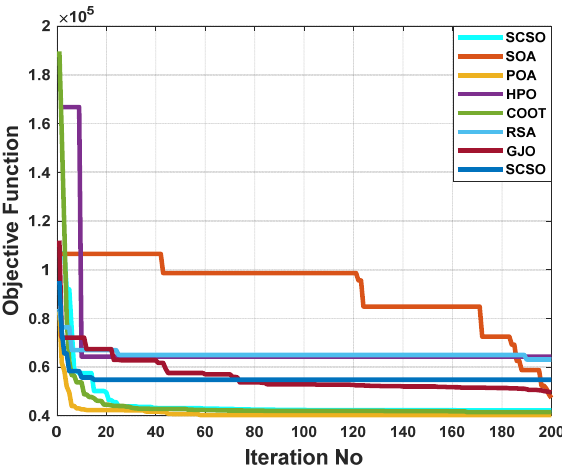
Figure 29. The convergence characteristics of POA and other compared algorithms for case 5 in a standard IEEE 57-bus test system.